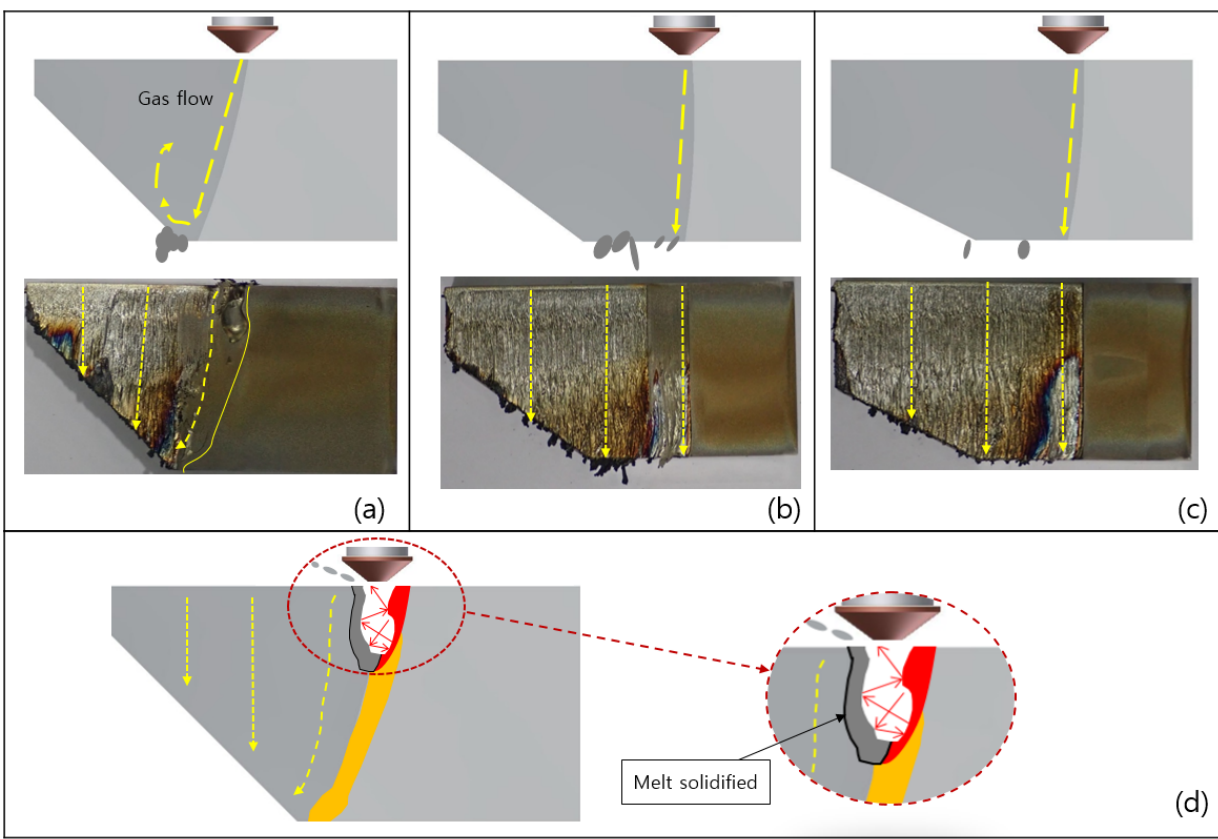
Figure 4. Longitudinal cross section of cut specimen: ( a ) case 2, ( b ) case 3, and ( c ) case 4. ( d ) Schematic of case 2 cause analysis.